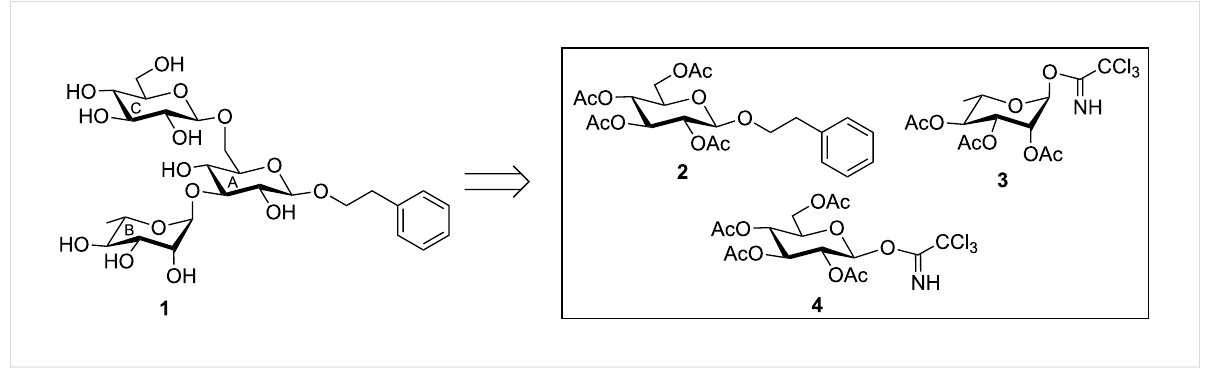
Figure 1: Structure of the synthesized trisaccharide core found in kankanose, kankanoside F, H 1 , H 2 and I isolated from Cistanche tubulosa.